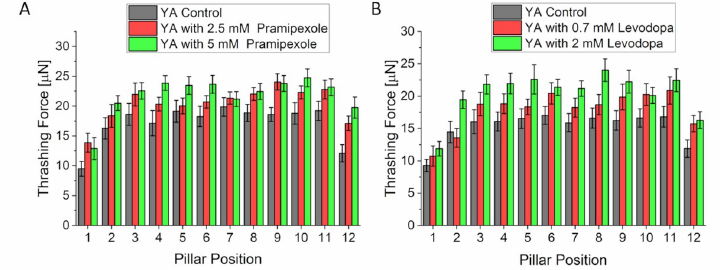
between average force values of control and treated worms, error bars indicate